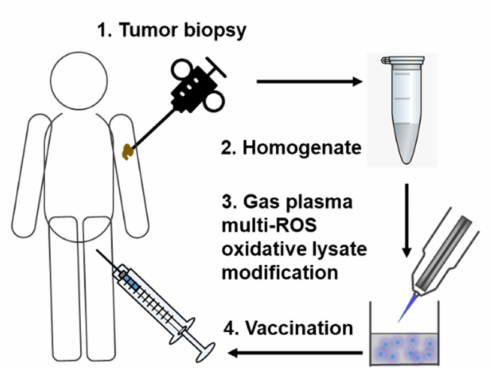
Figure 2. Simplified scheme of gas plasma technology-mediated multi-ROS-driven improvement of autologous tumor vaccines. After tumor biopsy and homogenization of the tumor material, oxidation with complex multi-ROS cocktails generated by medical gas plasma jet technology follows prior to